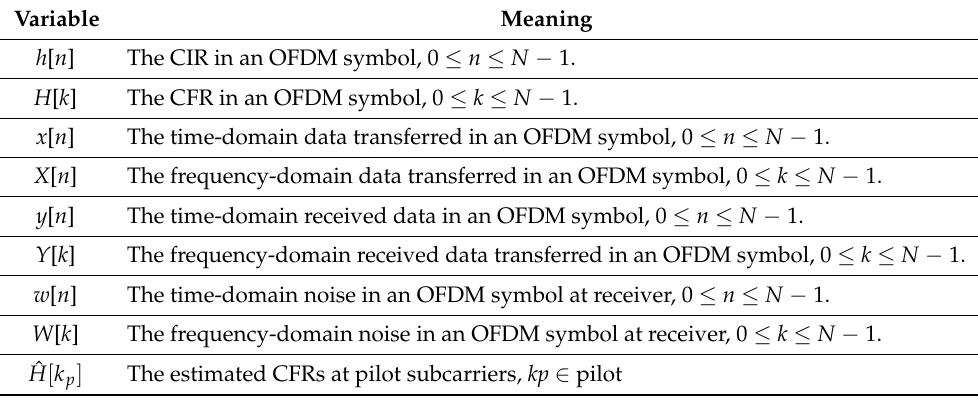
Table 2. Variable